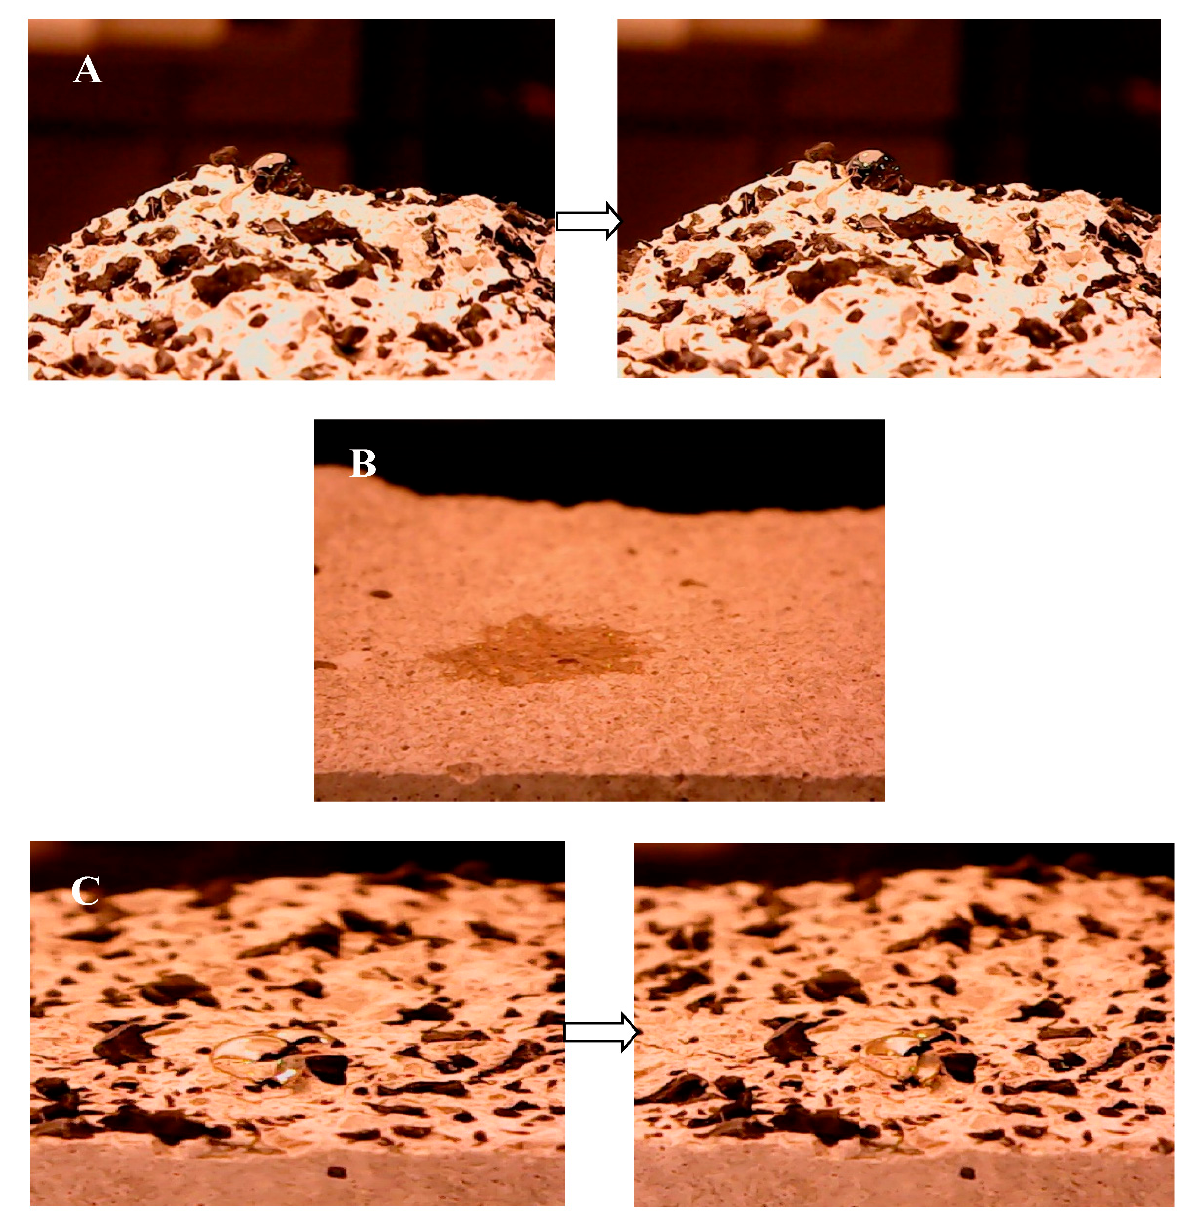
Figure 14. Wettability tests on the fracture surface of ( A ) TR F sample (sample 1) at t = 0 s ( left ) and at t = 150 s ( right ), ( B ) P sample (sample 10) at t = 1 s, ( C ) P/TR F sample (sample 11) at t = 0 s ( left ) and at t = 150 s ( right ).